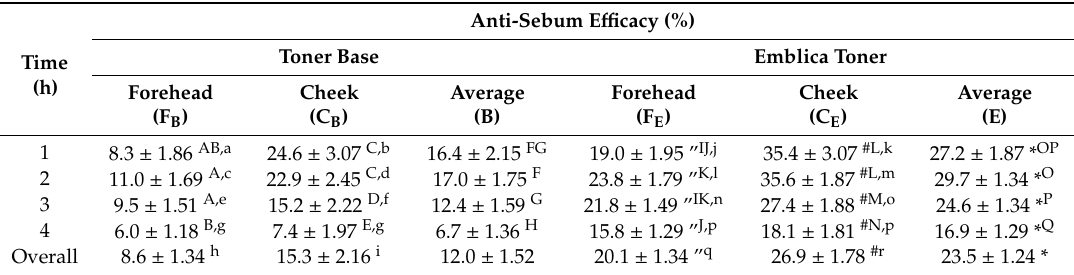
Table 3. Anti-sebum efficacy of toners on the forehead and cheek skin ( F C , F B , F E , C B , C E ) and the average (E) at 1, 2, 3, and 4 h of 30 volunteers (from Equation (3)).